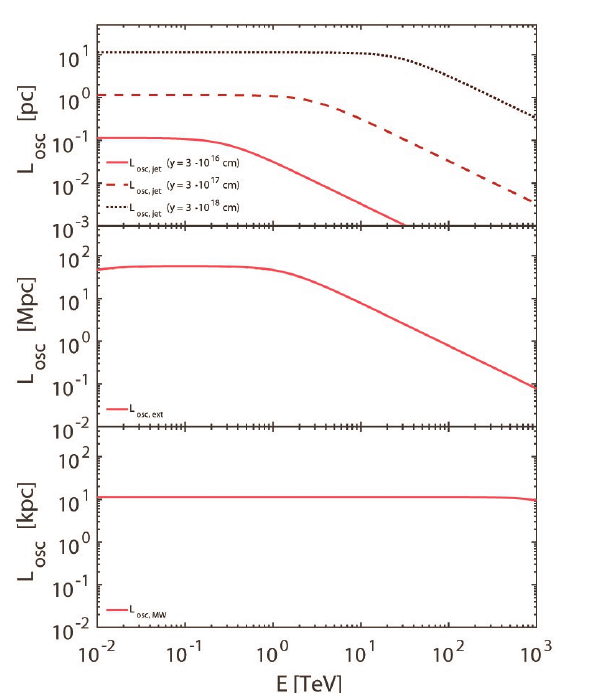
Figure 24. We exhibit the oscillation length L osc versus the observed energy E in the various regions crossed by the photon/ALP beam. The upper panel refers to the propagation in the jet: in this case ( y ) at different distances from the emission region. We L osc strongly depends on the value of B T , R jet plot L osc at (i) the emission distance y = y VHE = 3 · 10 16 cm (solid line), (ii) y = 10 y VHE = 3 · 10 17 cm (dashed line) and (iii) y = 100 y VHE = 3 · 10 18 cm (dotted line). In the central panel we draw the behaviour of L osc versus E in the extragalactic space while in the lower panel the behaviour of L osc versus E in the Milky Way. (Credit